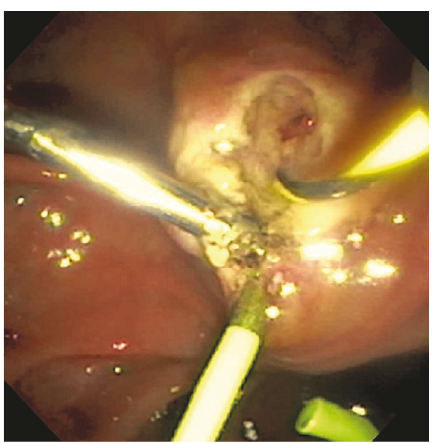
Figure 2: View of the ampulla of Vater following needle-knife fistulotomy, CBD cannulation, and pancreatic duct stent placement around the hemostatic